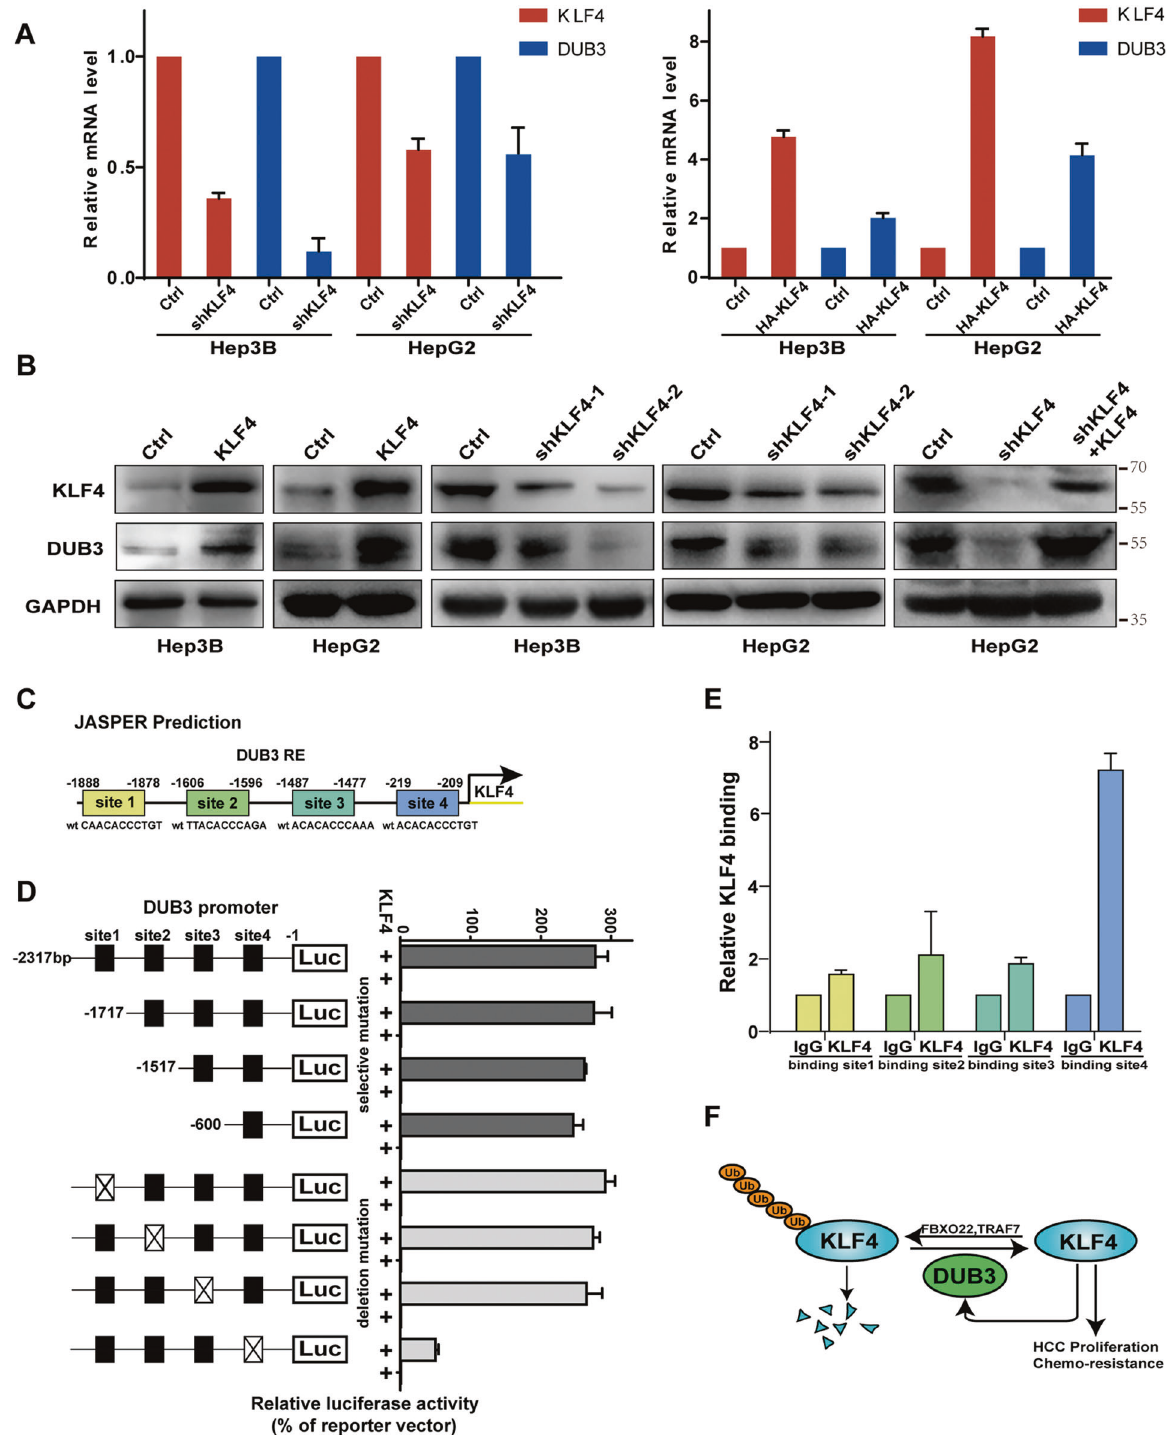
Fig. 6 KLF4 promoted DUB3 transcription by binding to the DUB3 gene promoter. A Hep3B and HepG2 cells were stably transfected with vectors expressing shKLF4 or HA-KLF4. qRT-PCR was performed to measure the mRNA levels of DUB3 and KLF4. B Hep3B and HepG2 cells were stably transfected with vectors expressing shKLF4 and KLF4 alone or in combination. Western blot analysis was conducted to determine protein expression of DUB3 and KLF4. C The potential binding sites of KLF4 on DUB3 promoter were predicted using the JASPAR database (http://jaspar.genereg.net/). D 293T cells stably expressing control or KLF4 were transfected with the luciferase reporter plasmids containing the wild-type DUB3 promoter or DUB3 promoter with indicated deletion mutation (site 1, − 1888 to − 1878; site 2, − 1606 to − 1596; site 3, − 1487 to − 1477; site 4, − 219 to − 209). The relative luciferase activity was determined at 24 h after transfection. E ChIP assay was conducted using anti-IgG or anti-KLF4 antibody to identify the binding site of KLF4 on the DUB3 promoter in 293T cells. F A schematic diagram illustrates the DUB3/KLF4 positive feedback loop that inhibits tumor growth and overcomes chemoresistance in HCC.